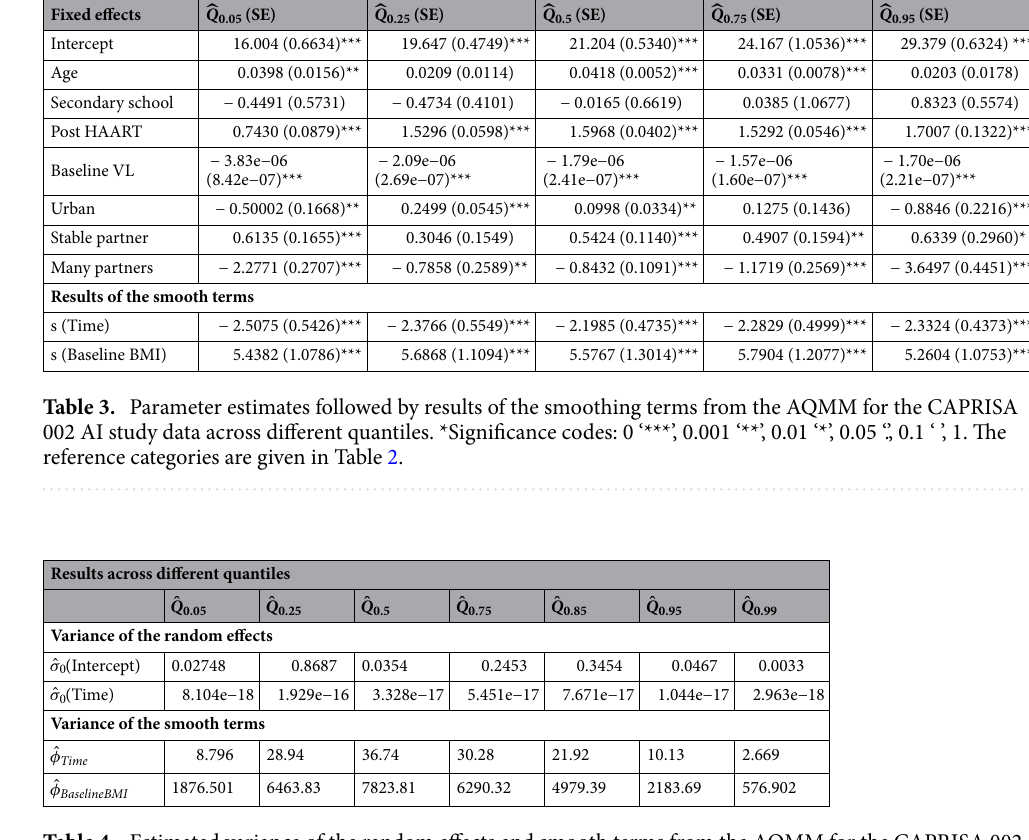
Table 4. Estimated variance of the random effects and smooth terms from the AQMM for the CAPRISA 002 AI study data.